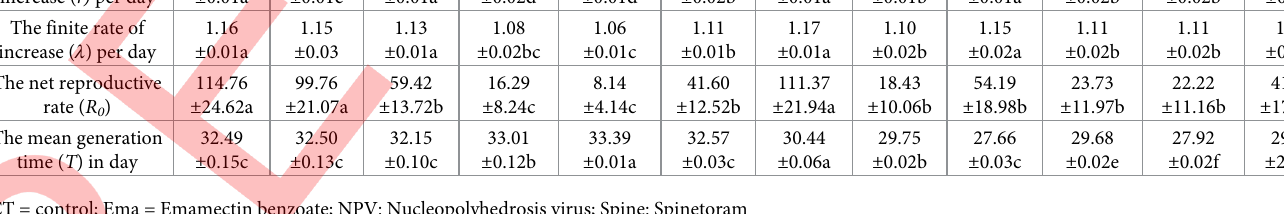
Table 3. Effect of HaNPV, insecticides and their combinations on emamectin benzoate selected and unselected population of Helicoverpa armigera . Parameter Selected Unselected CT Spine The intrinsic rate of 0.14 increase ( r) per day The finite rate of increase ( λ ) per day The net reproductive rate ( R 0 ) The mean generation time ( T ) in day CT = control; Ema = Emamectin benzoate; NPV: Nucleopolyhedrosis virus; Spine: Spinetoram Lettering in rows is showing significant difference; Values are compared for selected and unselected population separately